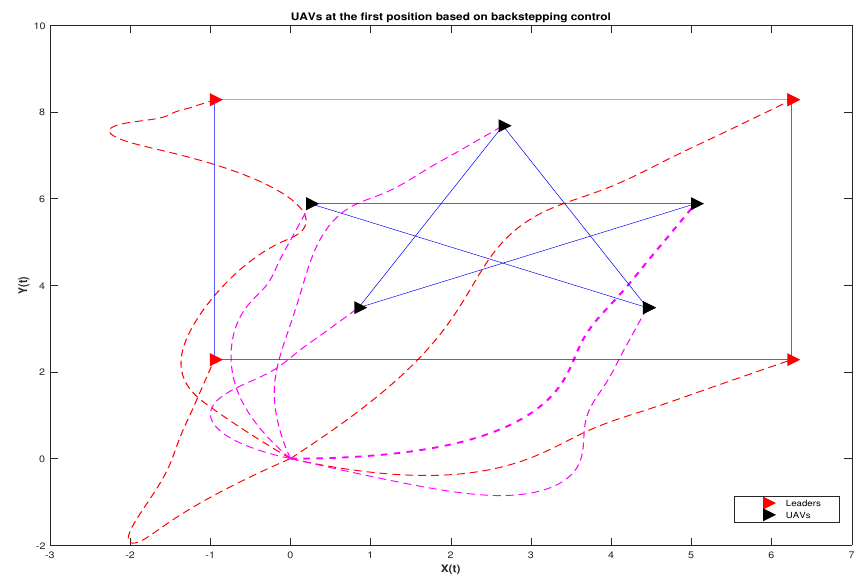
Figure 7. UAVs containment at the first position based on Backstepping control without parameters uncertain.